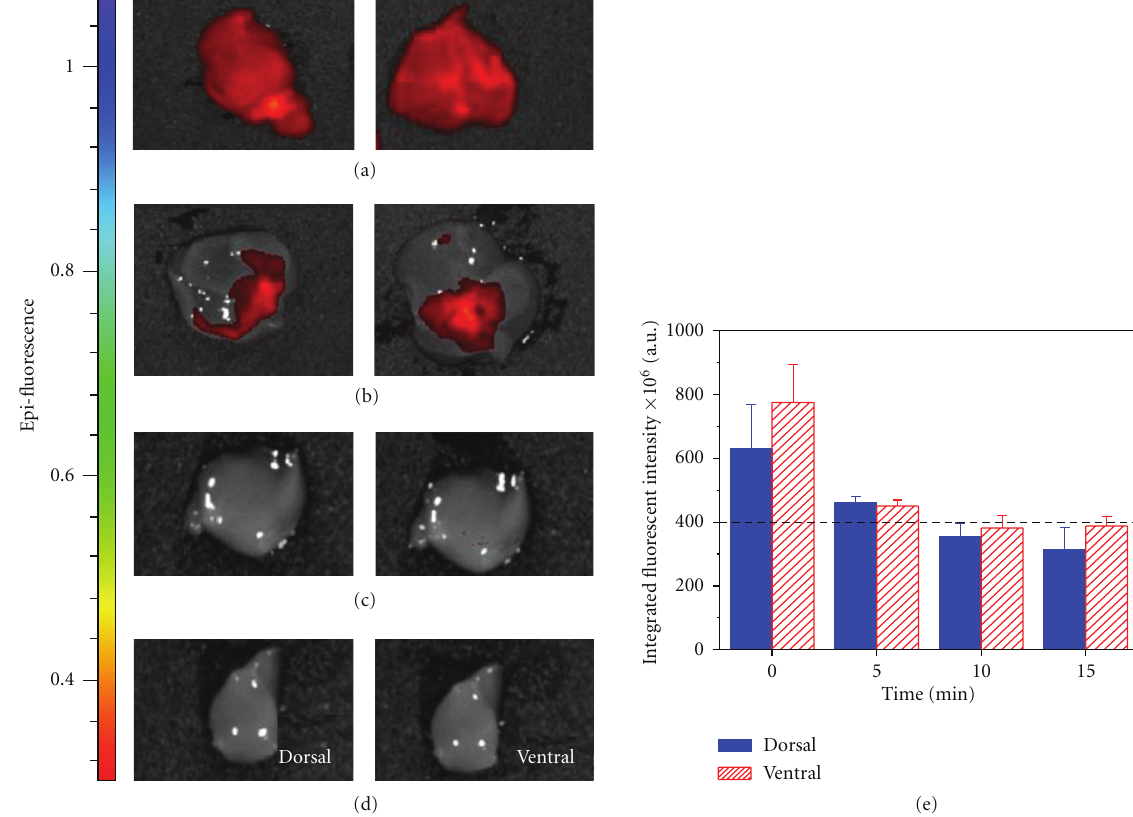
Figure 4: Blocking study for nonspecific staining using liver. (a) no blocking—0 min; (b) 5min blocking; (c) 10min blocking; (d) 15 min blocking; (e) quantification of the integrated fluorescent intensity versus time. Dash-line indicates acceptable background signal.